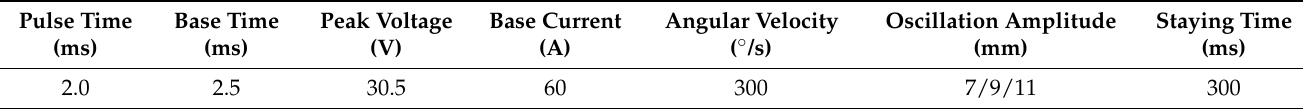
Table 5. Pulse parameters and oscillation parameters set in the machines.